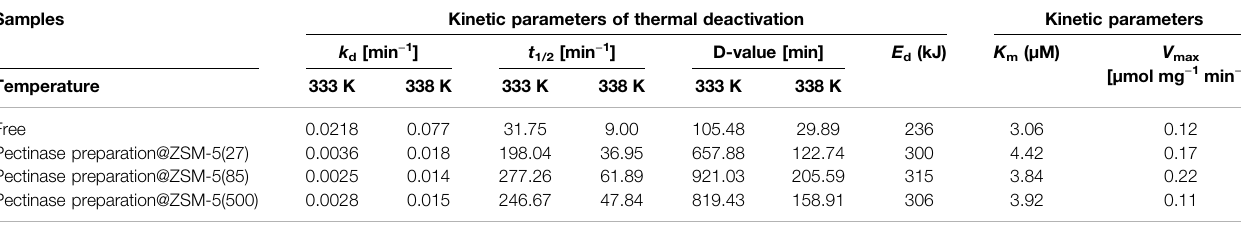
TABLE 1 | Kinetic parameters of pectinase preparation@ZSM-5 and free pectinase preparation. Samples